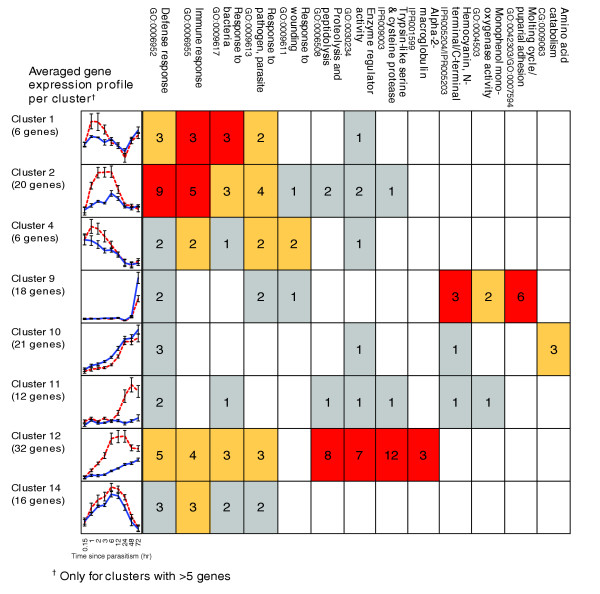
Gene expression profiles and functional annotations for the eight largest clusters of co-expressed genes. On the left-hand side the average expression levels for the genes in the eight clusters are shown (log2-transformed expression values, divided by the median for that gene across all time points and treatments). Dashed lines represent parasitized and unbroken lines represent unparasitized larvae, and the bars indicate standard errors. Functional annotations associated with clusters are shown along the top, and colors in the matrix indicate the strength of association (yellow = Ease scores (see text) <0.05; red = after Bonferroni correction at P < 0.05; grey = at least one gene with this annotation). The full annotation for all probe sets is provided in Additional data file 1.